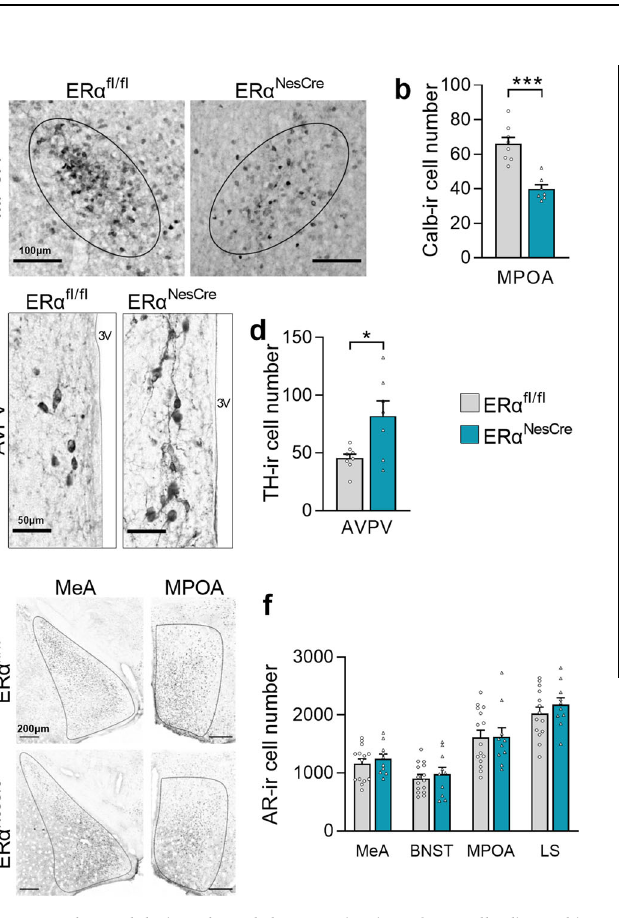
produce the fi rst litter (20.33 ± 0.33 days versus 27.67 ± 0.67 days for controls), the number of litters (7.33 ± 0.29 versus 7.33 ± 0.33 for controls) and litter size (6.26 ± 0.93 versus 6.77 ± 0.76 for controls) were comparable between the two genotypes.